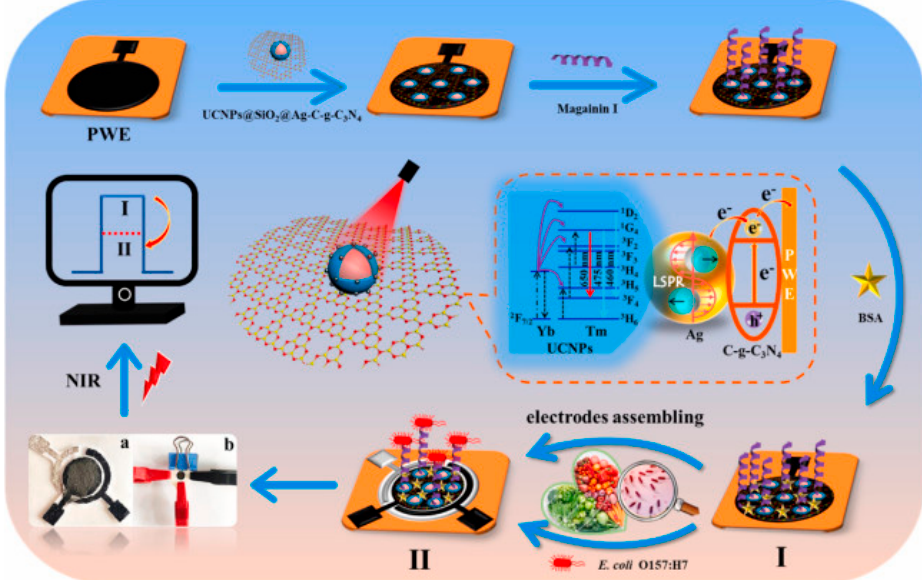
Figure 8. Schematic fabrication process of the PEC sensing platform for the detection of E. coli O157:H7. (I) Assembly of UCNPs@SiO 2 @Ag/C-g-C 3 N 4 , Magainin I and BSA onto PWE (II) PEC response of fabricated sensing platform under NIR light of 980 nm (a) photograph of modified PWE, Ag/AgCl reference electrode and carbon counter electrode assembled randomly on paper, (b) lab- on-paper PEC platform [122]. Copyright 2022, Elsevier.